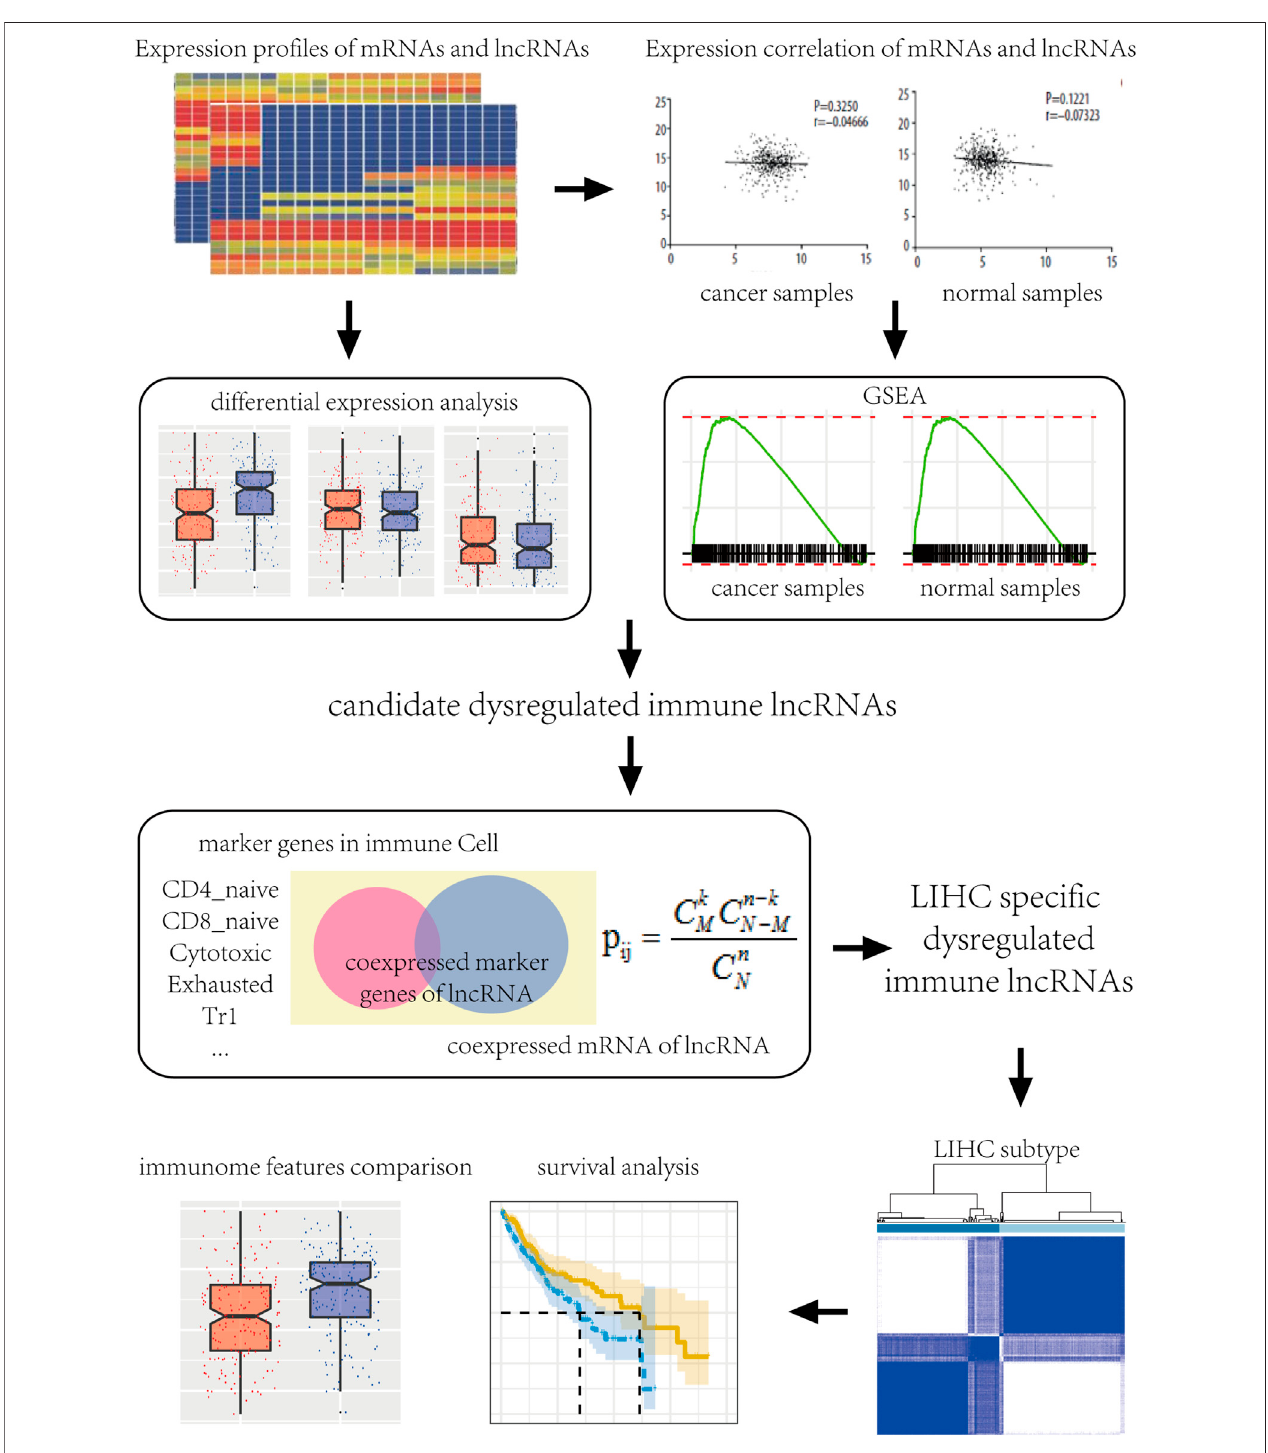
FIGURE 1 | Work fl ow